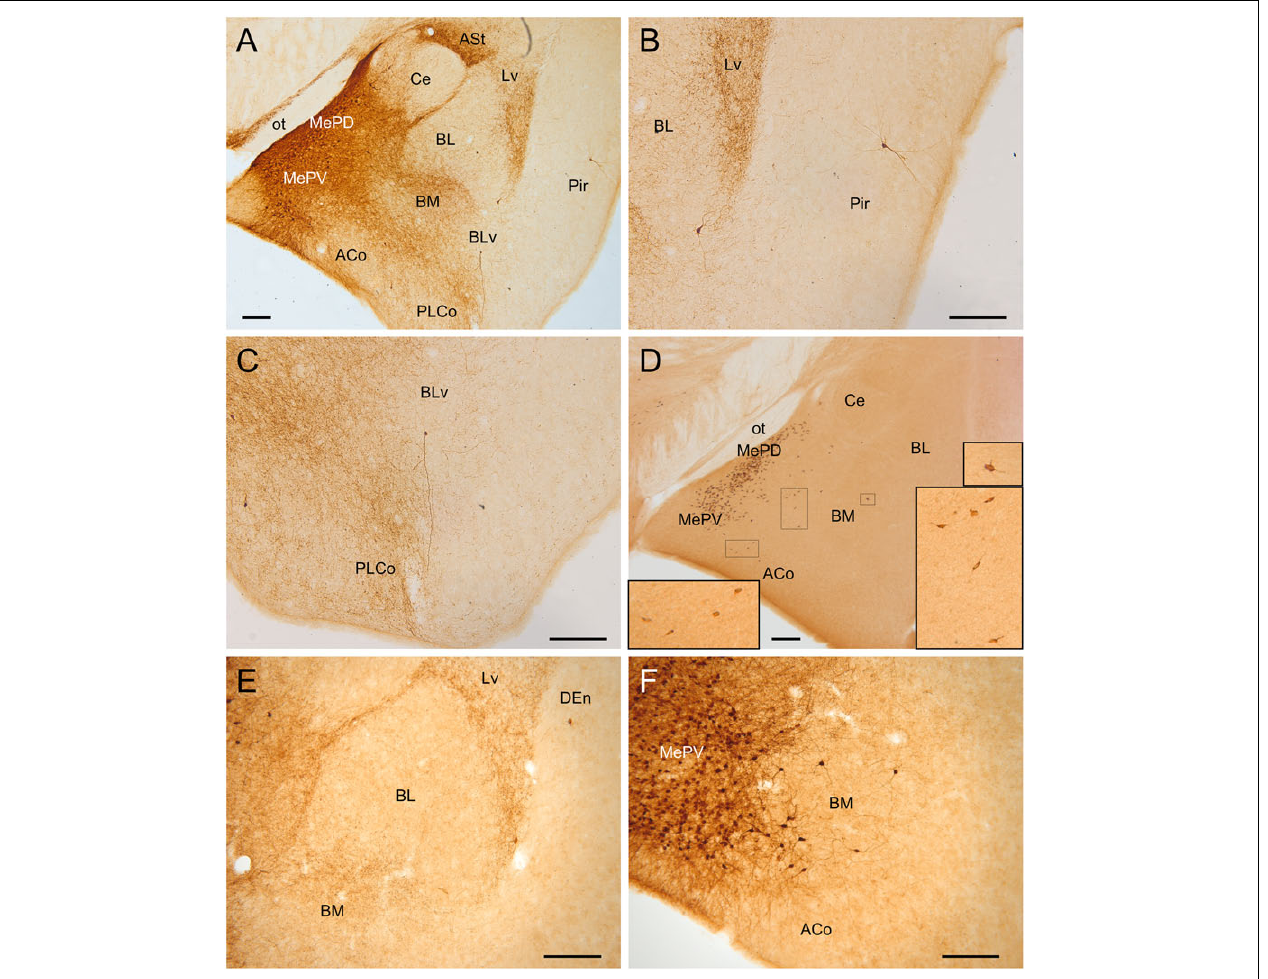
FIGURE 4 | GFP and HA immunoreactivity in the adult amygdala. Images of frontal brain sections of adult Otp-eGFP mice (A–C,E,F) and Otp-Cre; Rpl22-HA mice (D) , showing GFP or HA immunoreactive cells in the amygdala. In the Otp-eGFP mice, the neuropil also shows immunoreactivity, allowing analysis of Otp-specific networks. Note the highly similar distribution of cells in the medial and pallial amygdala in both transgenic mice. In the pallial amygdala, some cells are seen in the anterior cortical amygdalar area (ACo) and the basomedial nucleus (BM), but a few cells are also seen in the ventrolateral part of the lateral nucleus (Lv) and the ventral part of the basolateral nucleus (BLv). In addition, a few cells are visible in the endopiriform nucleus and piriform cortex. See text and abbreviation list for more details. Scale bar: panels (A–F) = 200 µ